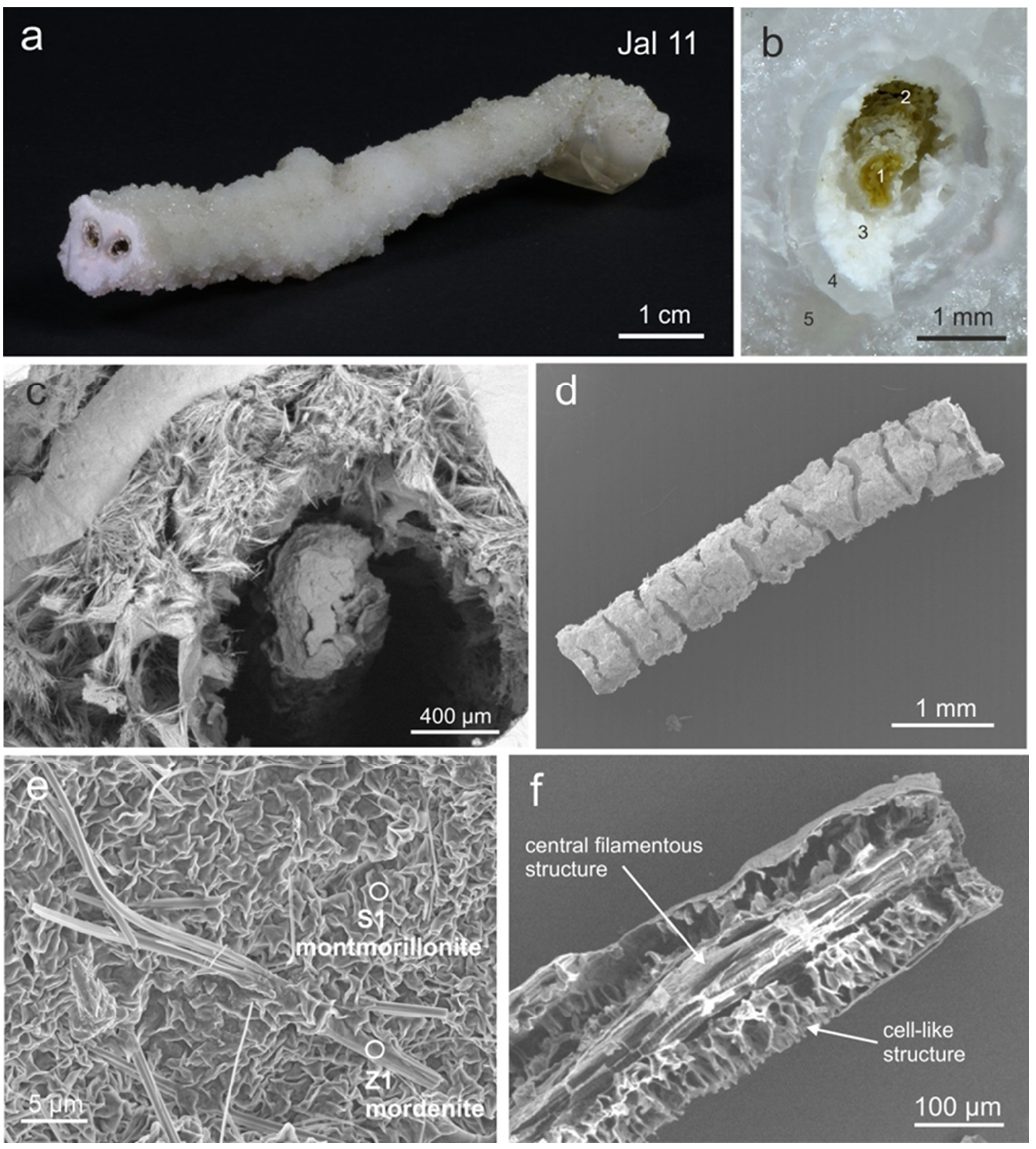
Figure 11. Micrographs of sample Jal 11 (Jalgaon/Savda). ( a ) SiO 2 aggregate showing two filamentous cores. ( b ) Cross-cut of the SiO 2 aggregate showing a greenish filamentous core (1), a tubular hole around the filament core (2), needle-like crystals of zeolites (mordenite (3)), chalcedony intergrown with mordenite (4) and more or less pure chalcedony (5). ( c ) SEM micrograph showing details of the cross-section with filamentous core and surrounding hole as well as fibrous crystals of mordenite. ( d ) SEM image of a loose part of a filamentous core. ( e ) Magnified part of (d) showing an irregular surface of smectite (montmorillonite) and mordenite fibers; S1 and Z1 relate to the EDX measurements in Table S2. ( f ) SEM image of a longitudinal cut of a filamentous core (200 µ m diameter) showing a central fibrous structure (ca. 20–40 µ m) and a marginal cell-like structure; the inner filament zone consists of several thread strands with a diameter of approx. 5 µm.